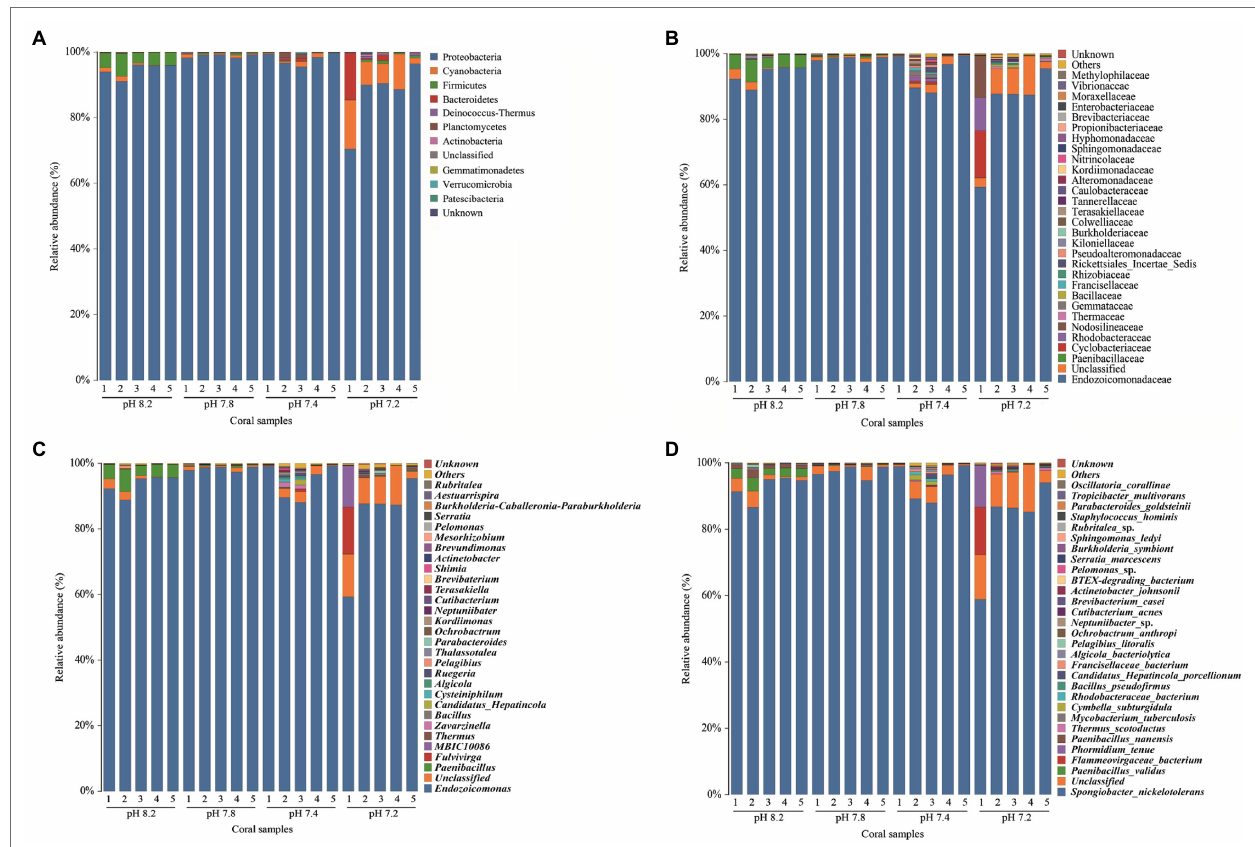
FIGURE 5 | Relative abundance of bacteria at different taxonomic levels in each pH group. (A) phylum, (B) family, (C) genus, and (D) species